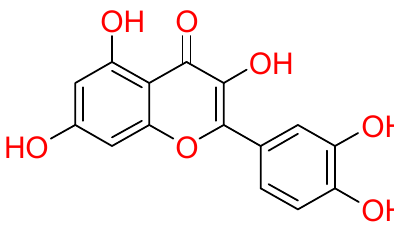
Figure 4. 2D structure of quercetin.